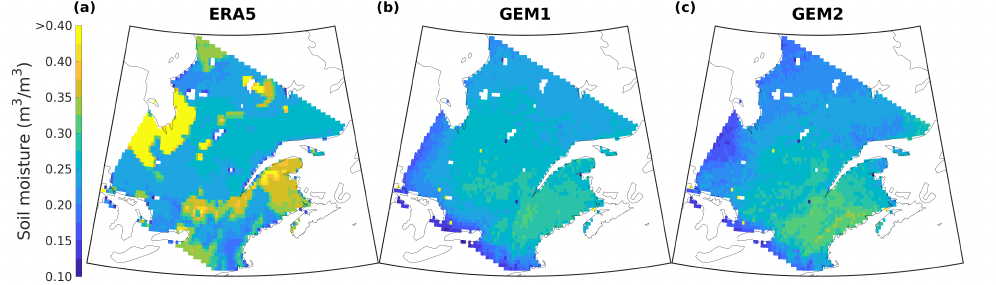
Figure 2. Mean surface soil moisture for the April–September period.( a ) ERA5, ( b ) GEM1 and ( c ) GEM2. The former two are mean values for the 1989–2020 period while that for GEM2 is the mean for